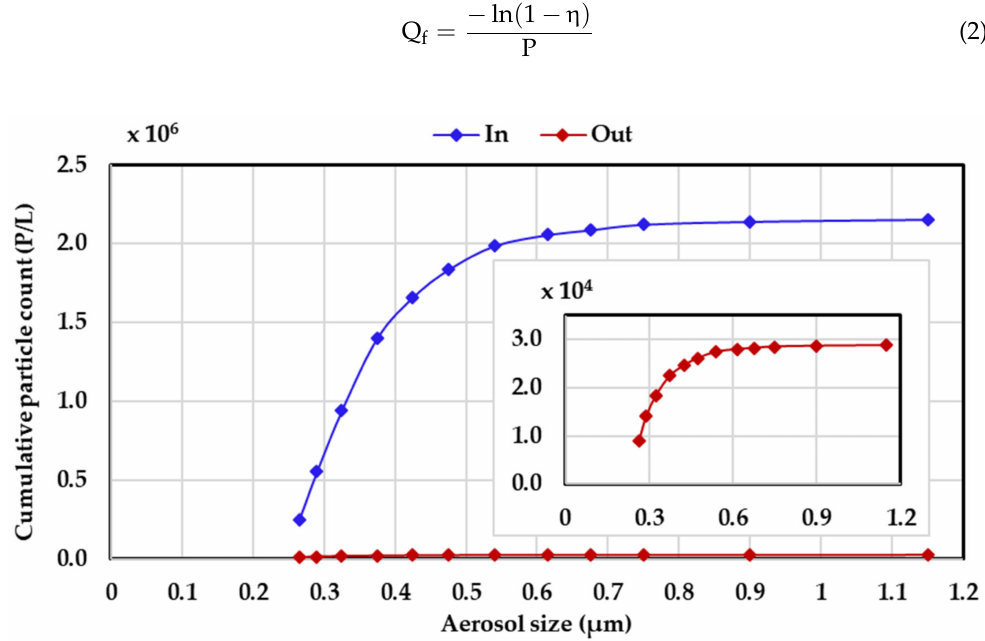
Figure 2. Particle size distribution of test particles before and after passage through the filter.